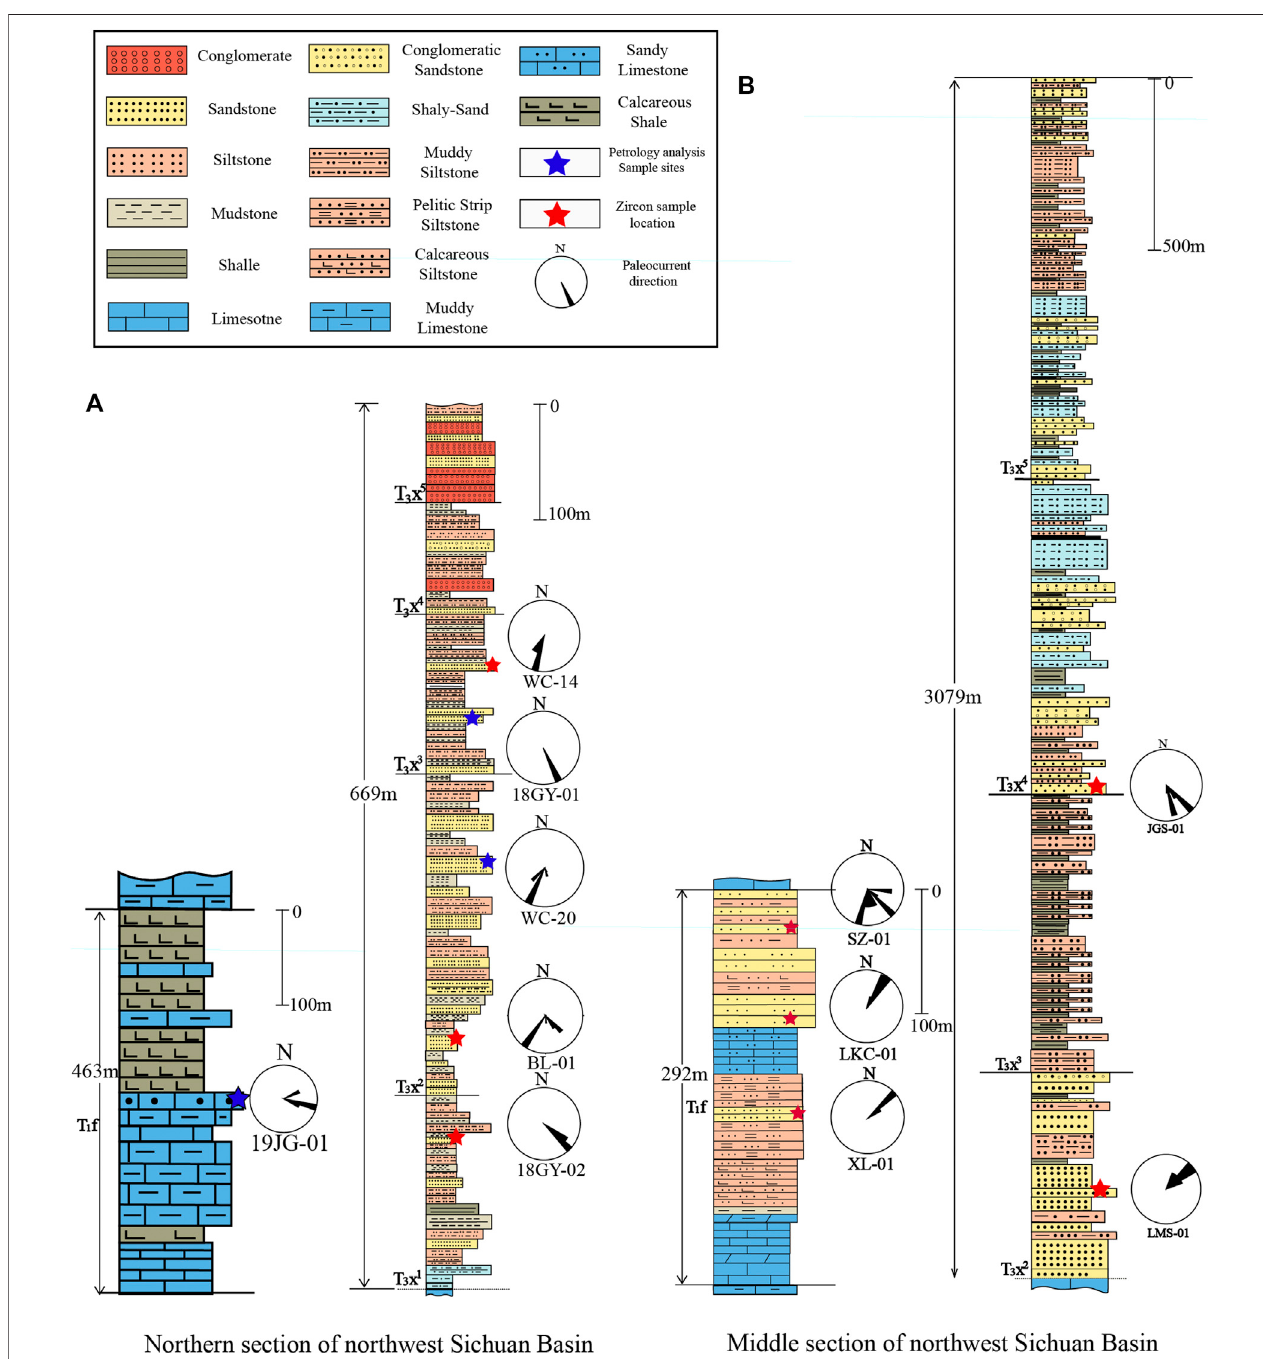
FIGURE 9 | Sedimentary stratigraphy of the Lower and Upper Triassic in the study area of Northwestern Sichuan Basin (modi fi ed after BGMRSP, 1991; Yu and Liang, 2016). (A) Northern section of the Northwestern Sichuan Basin. (B) Middle section of the Northwestern Sichuan Basin.